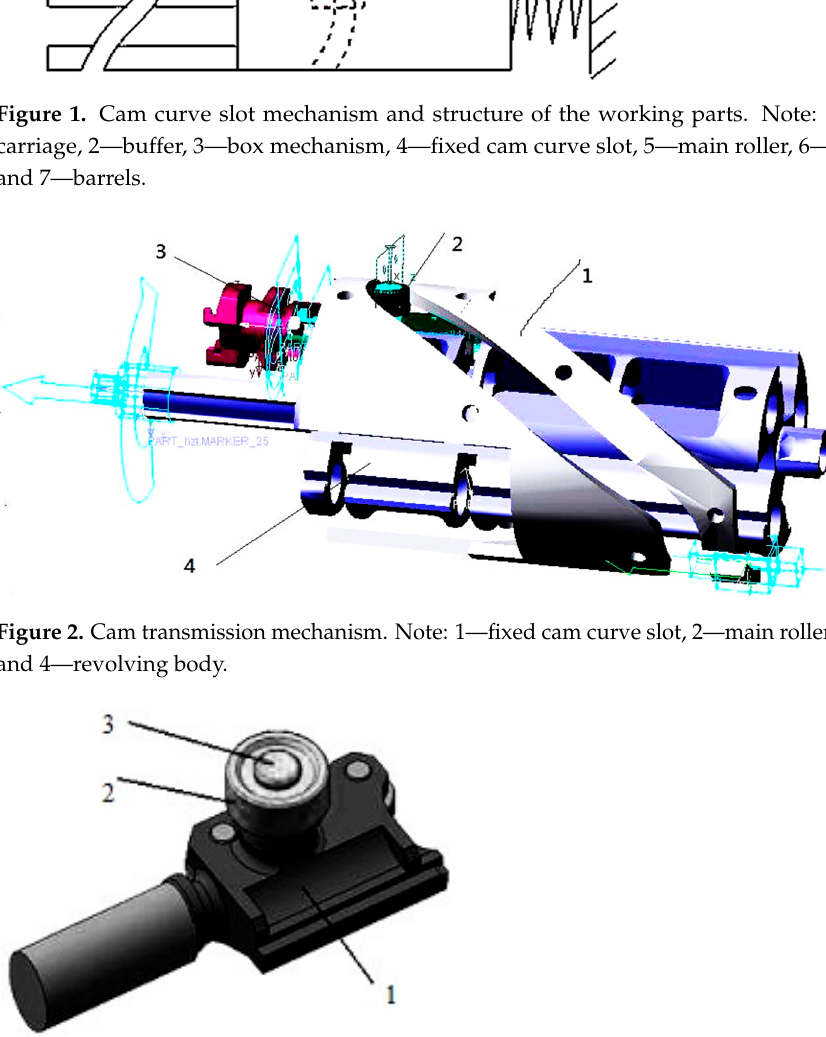
Figure 3. Bolt. Note: 1—bolt body, 2—main roller, and 3—the rolling axis.